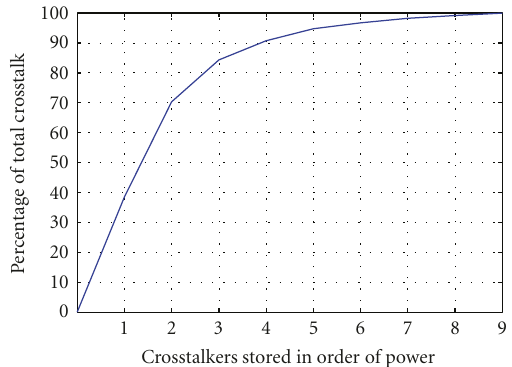
Figure 3: Cumulative average crosstalk percentages in DS direction for distributed Scenario 1 (crosstalkers are sorted by